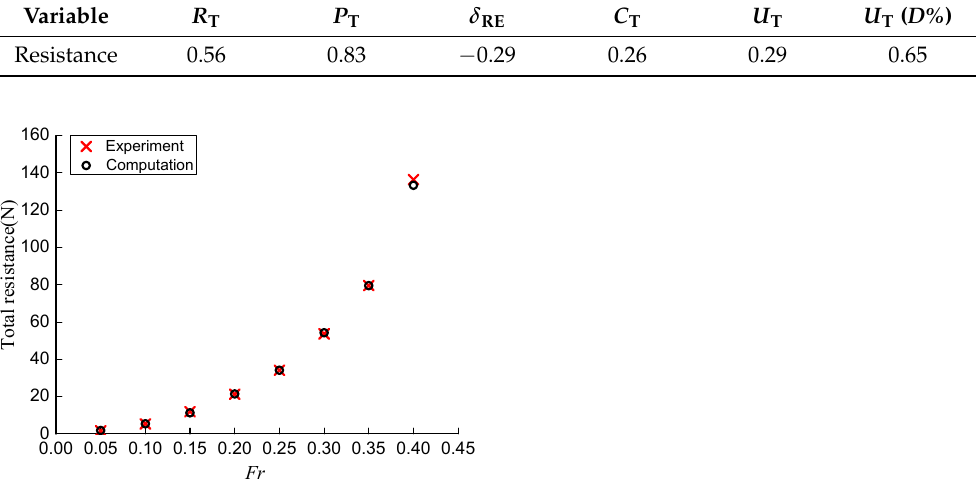
Figure 9. Comparison of total resistance obtained by computation and experiment for intact ship at different forward speeds.